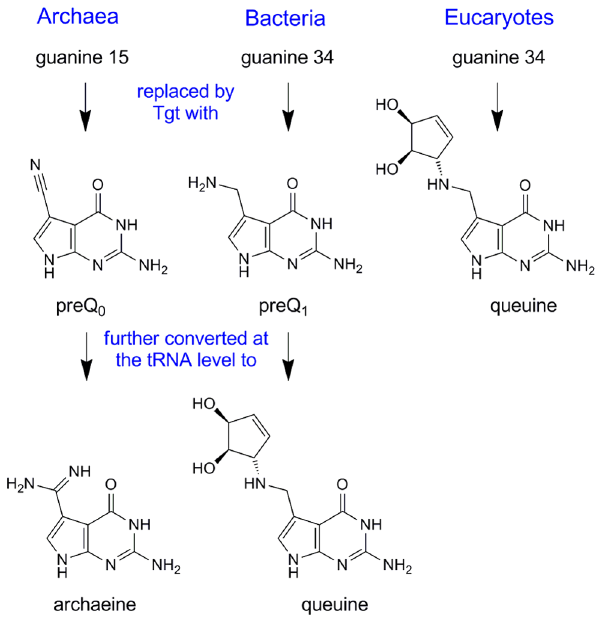
Figure 1. Substrate bases of the Tgt enzymes from the three domains of life. preQ 0 , 7-cyano-7-deazaguanine; preQ 1 , 7-amino- methyl-7-deazaguanine; queuine=7-(((4,5- cis -dihydroxy-2-cyclopenten- 1-yl) amino) methyl)-7-deazaguanine.